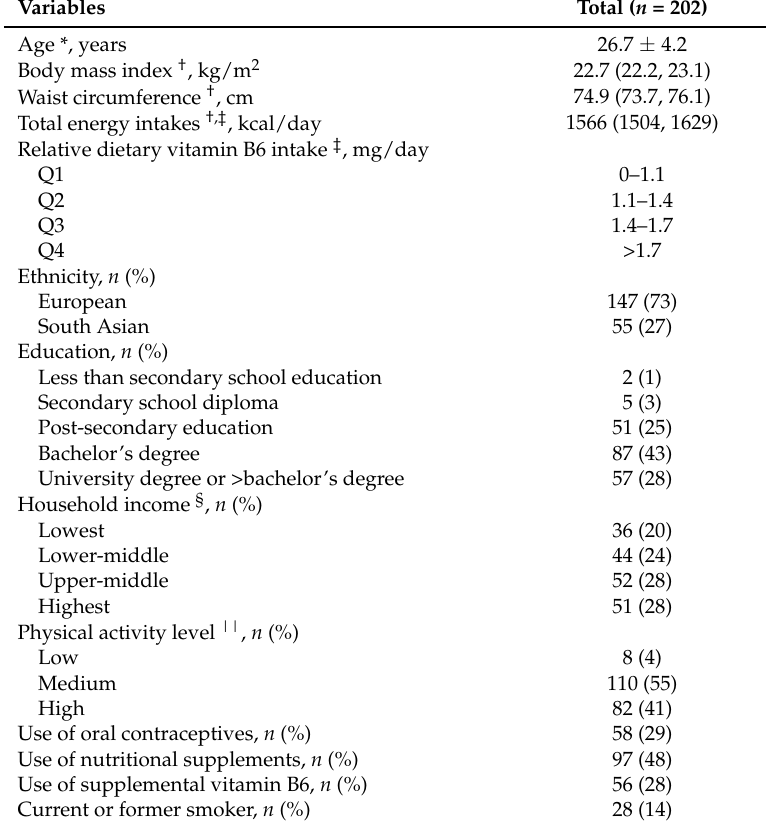
Table 1. Demographic and lifestyle characteristics of 202 healthy young adult women in Metro